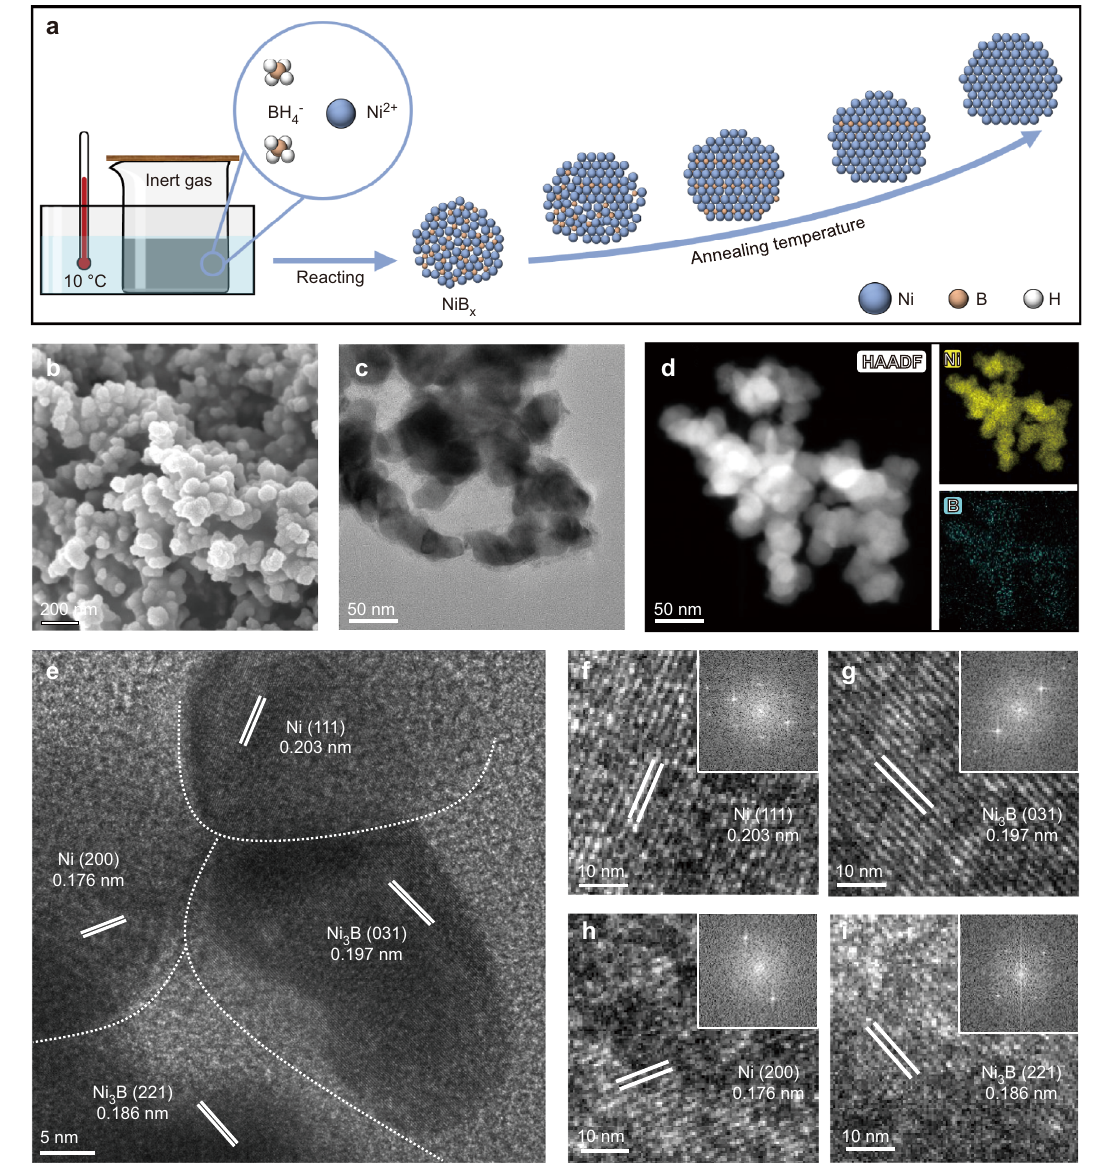
Fig. 1| Preparation andCharacterizationsofthenickelboride/nickelcatalysts. a Schematicdiagramofthecatalystpreparation. b SEMimageofthepreparedNiB- 400catalyst. c TEMimageofthepreparedNiB-400catalyst. d STEM-EDXimagesof